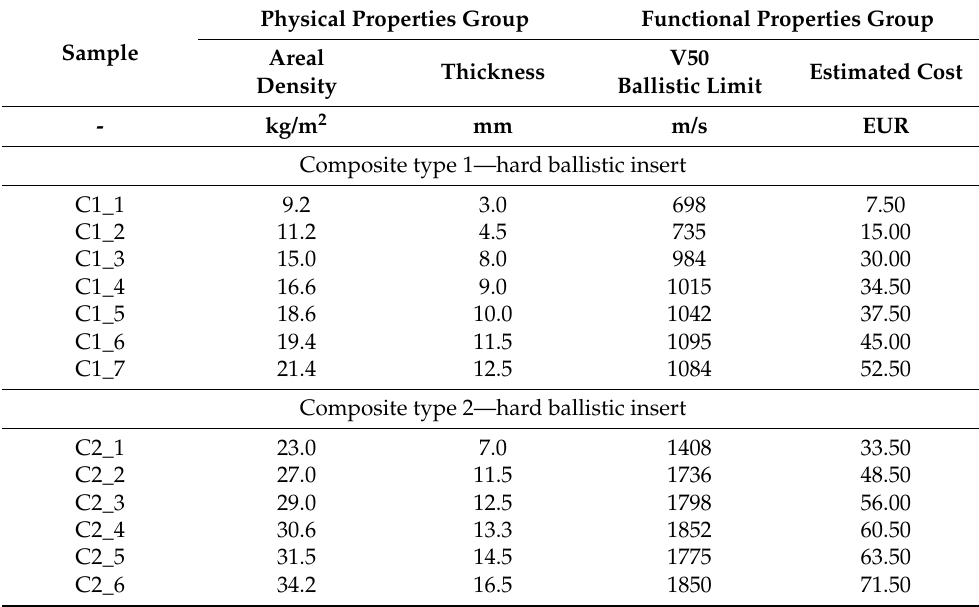
Table 7. Parameters of the designed para-aramid hard ballistic inserts selected in two groups: physical and functional properties.